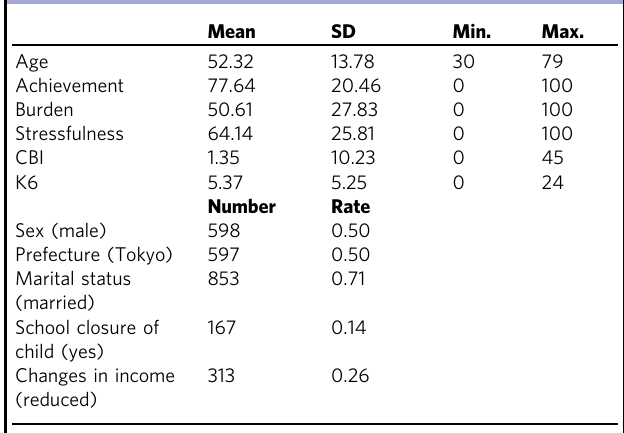
Table 1 Descriptive statistics for all the independent variables and psychological